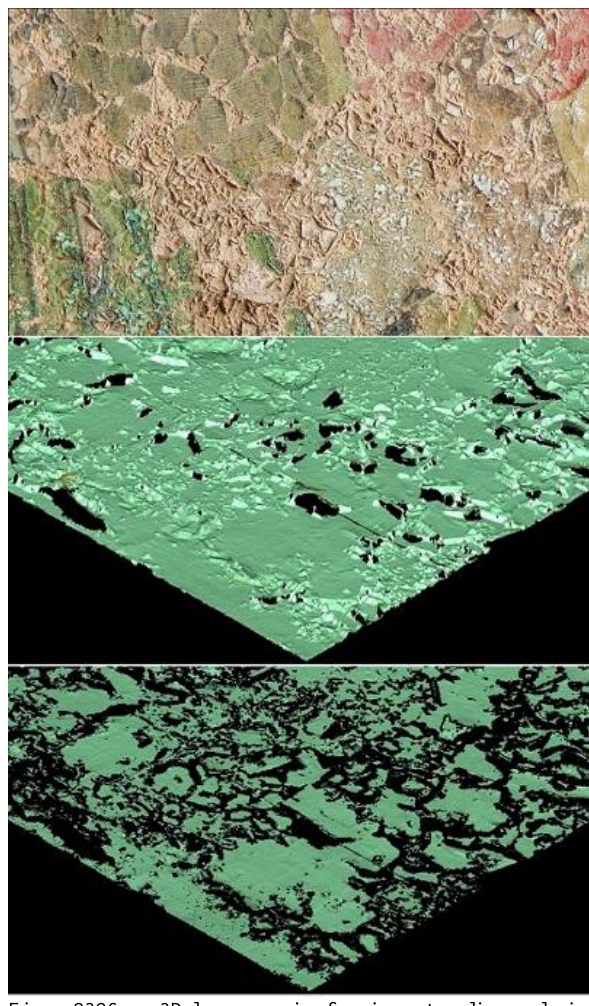
Figure 2326 use 3D laser scanning for pigment peeling analysis